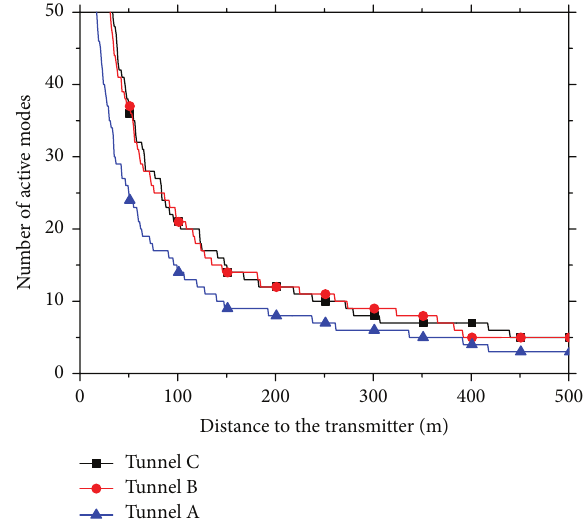
Figure 4: Comparison of the number of active modes tested in dif- ferent tunnels with the proposed modal